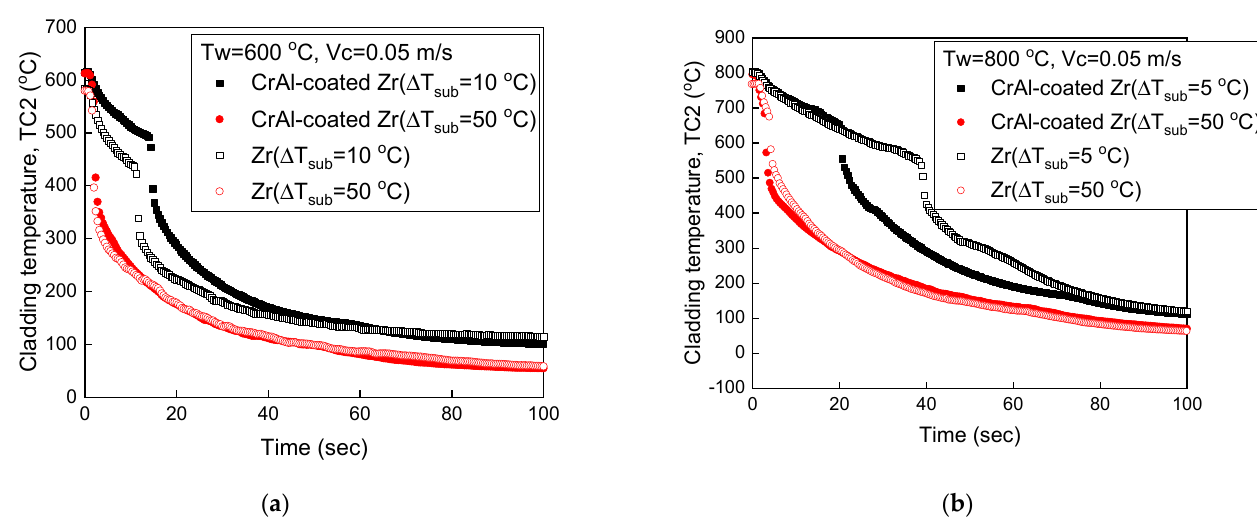
Figure 15. Comparison of quenching curves for Zr and CrAl-coated Zr at; ( a ) Tw = 600 °C; ( b ) Tw = 800 °C.